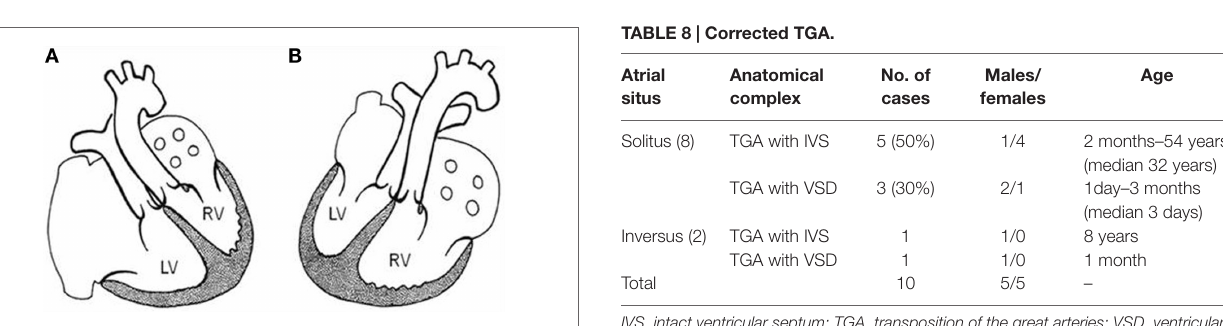
FigUre 10 | corrected Tga . Schematic representation of corrected TGA (discordant AV and VA connections) in situs solitus with levocardia (a) and in situs inversus with dextrocardia (B) . LV, left ventricle; RV, right ventricle.